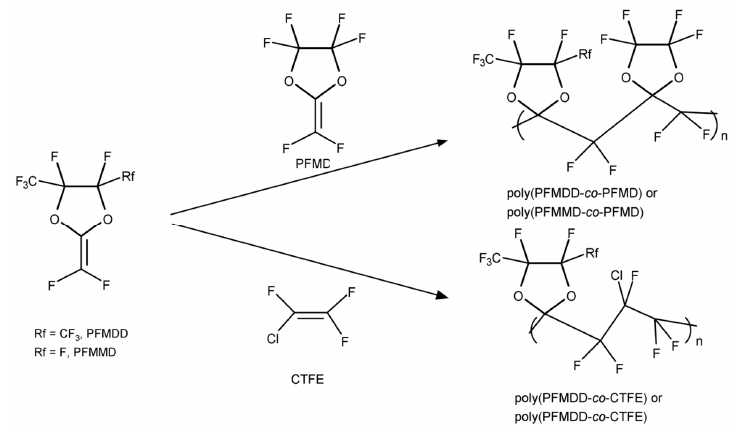
Figure 6. Chemical structures of the monomers for PFMDD, PFMMD, and CTFE, and the copolymers of poly(PFMDD- co -PFMD), poly(PFMDD- co -CTFE), and poly(PFMMD- co -CTFE) [24,27].